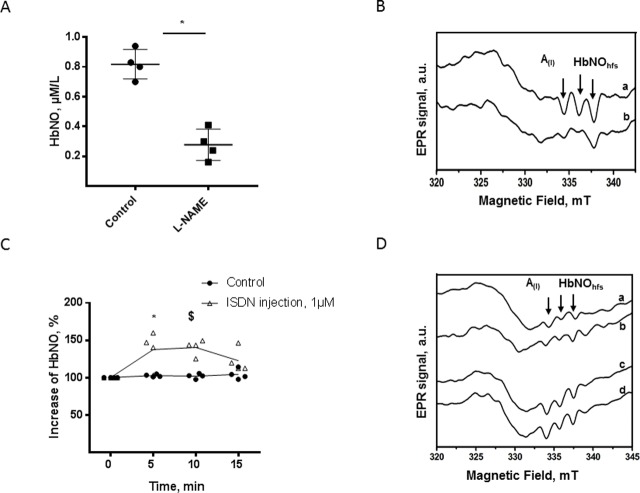
Sensitivity of blood HbNO formation to in vivo administered L-NAME or a nitrovasodilator.A. Concentration of HbNO in venous mouse RBCs after seven days of treatment with L-NAME or vehicle as described in Materials and Methods. B. Typical EPR spectra of HbNO recorded from isolated RBCs after one week administration of vehicle (a) or L-NAME (b) in drinking water. C. Kinetics of relative in vivo changes of HbNO EPR signal in venous rat blood after in vivo isosorbide dinitrate (ISDN) or vehicle injection. D. Typical HbNO EPR spectra after 5 and 10 minutes i.v. administration of vehicle (a-b) or isosorbide dinitrate (ISDN) (c-d). Data are shown as mean values ± SD; * P < 0.05 and $ P < 0.01; n = 4 different RBC preparations.